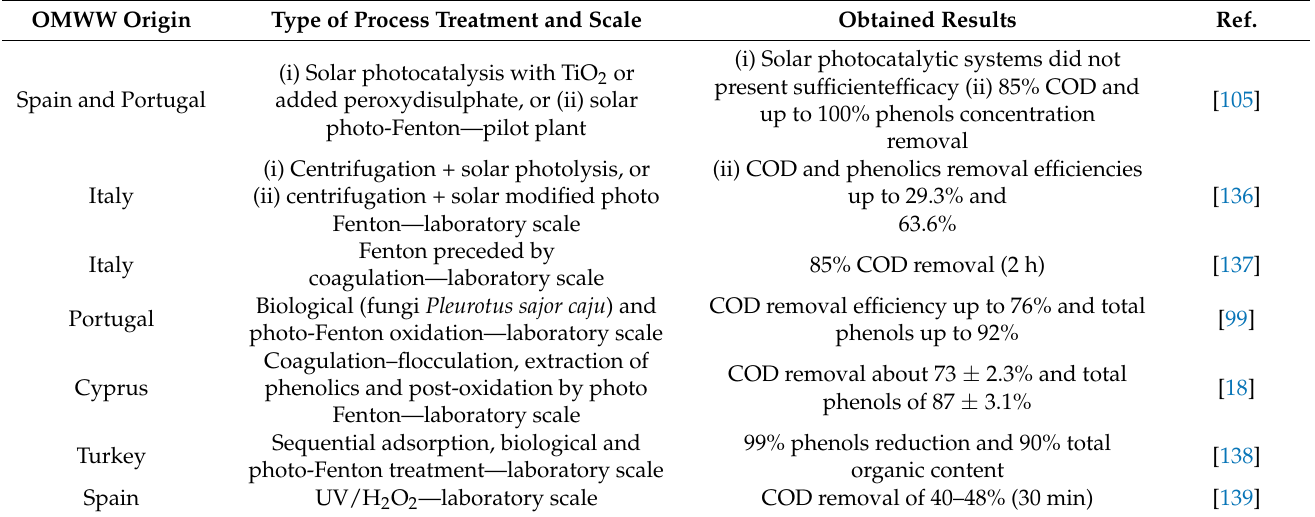
Table 3. State of the art in visible/solar photocatalytic processes for OMWW treatment. Adapted with permission from Reference [135].